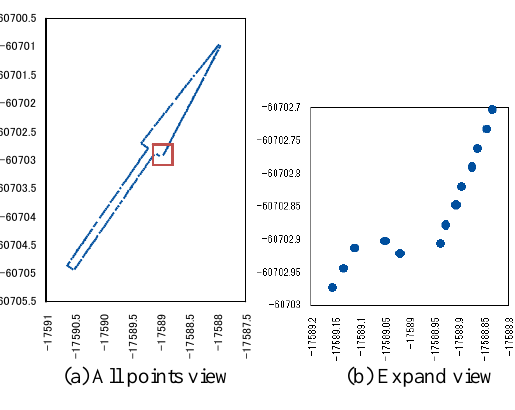
Figure 24. Filter